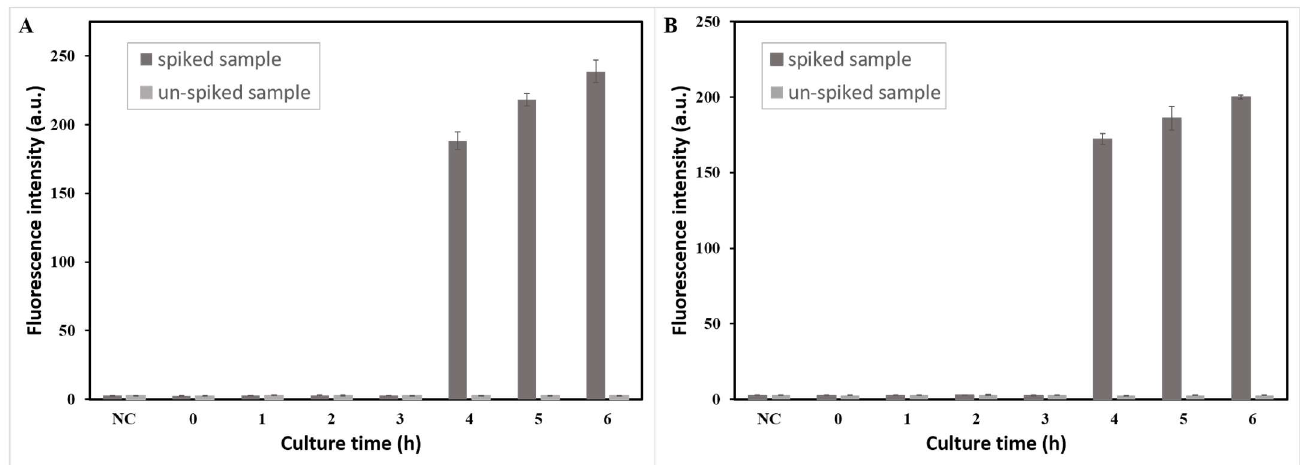
Figure 5. Minimum detection time test results of LAMP–CRISPR detection system for Salmonella detection in the ( A ) salmon sample and ( B ) chicken sample spiked and un-spiked.